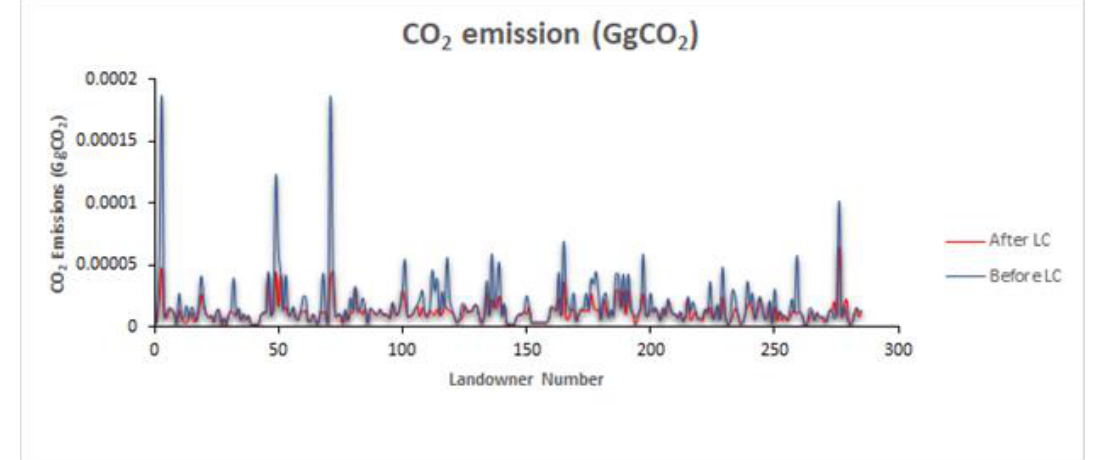
Figure 4. Changes in the carbon footprint values in individual enterprises after land consolidation (Selimiye Neighborhood).